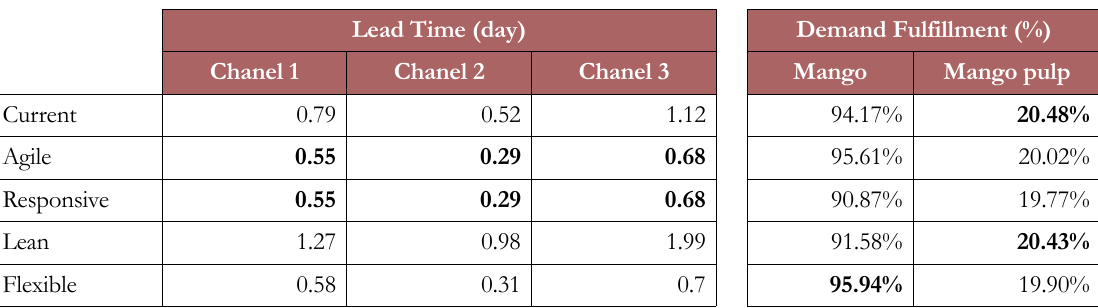
Table 4a. Leadtime and Demand fulfilment for Mango